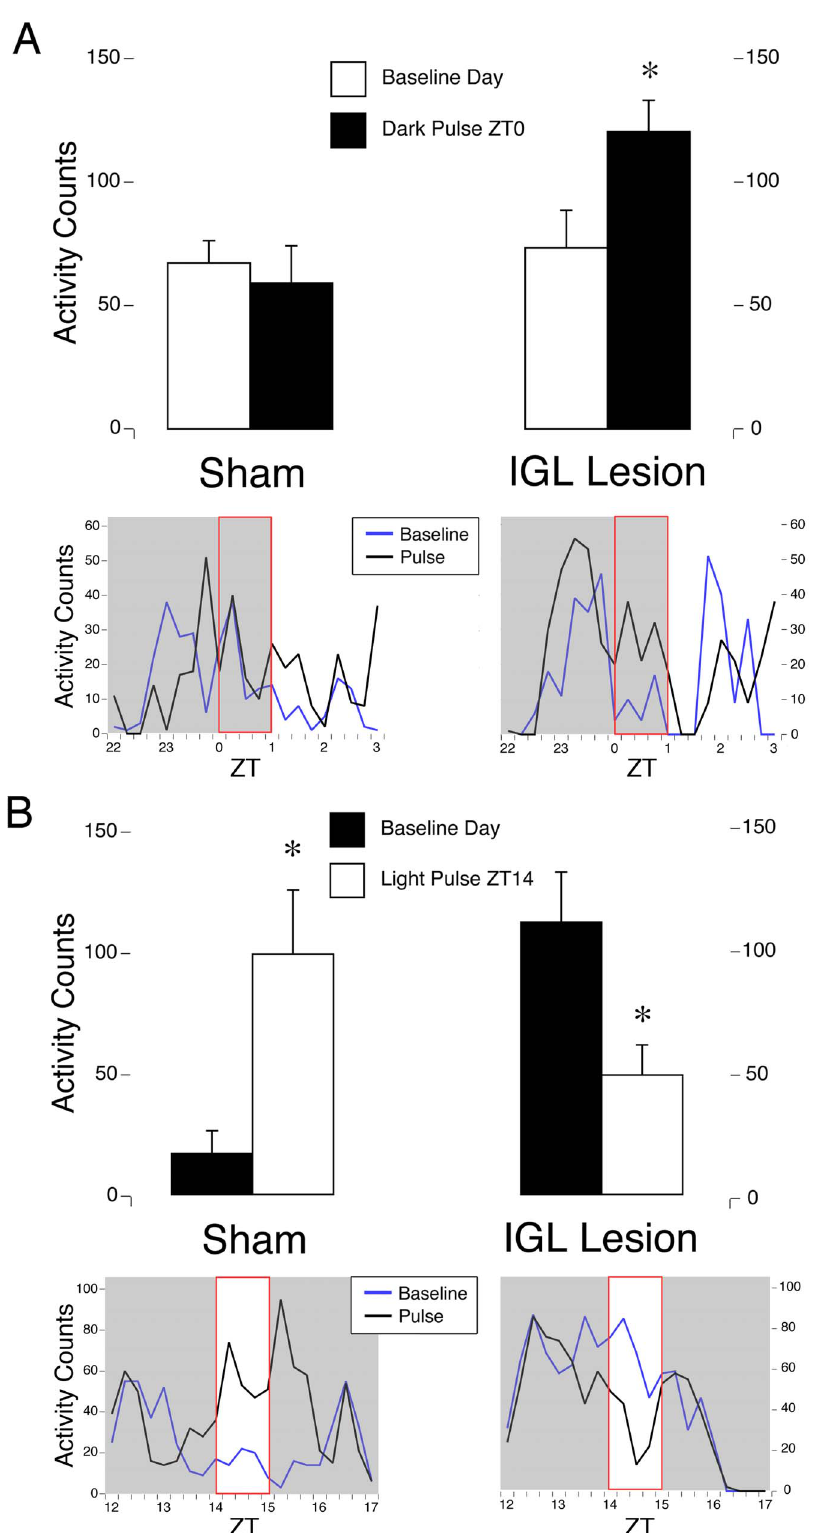
Figure 6. Masking responses to light and dark pulses. ( A ) Masking response to a dark pulse in LD conditions during the light phase at ZT0. In shams, activity was unchanged in response to dark pulses at ZT0. In animals with complete IGL lesions, dark pulses resulted in a significant increase in activity at ZT0. * = significant difference between baseline day (White bars) vs. 1-h dark pulse (Black bars). Means + SE. Representative activity patterns for 2-h prior to, 1-h during, and 2-h following the dark pulse are presented for one sham (left) and one IGL lesioned animal (right) during a baseline day (blue line) and on a day when dark pulse was presented at ZT0 (black line). ( B ) Response to a light pulse in LD during the dark phase at